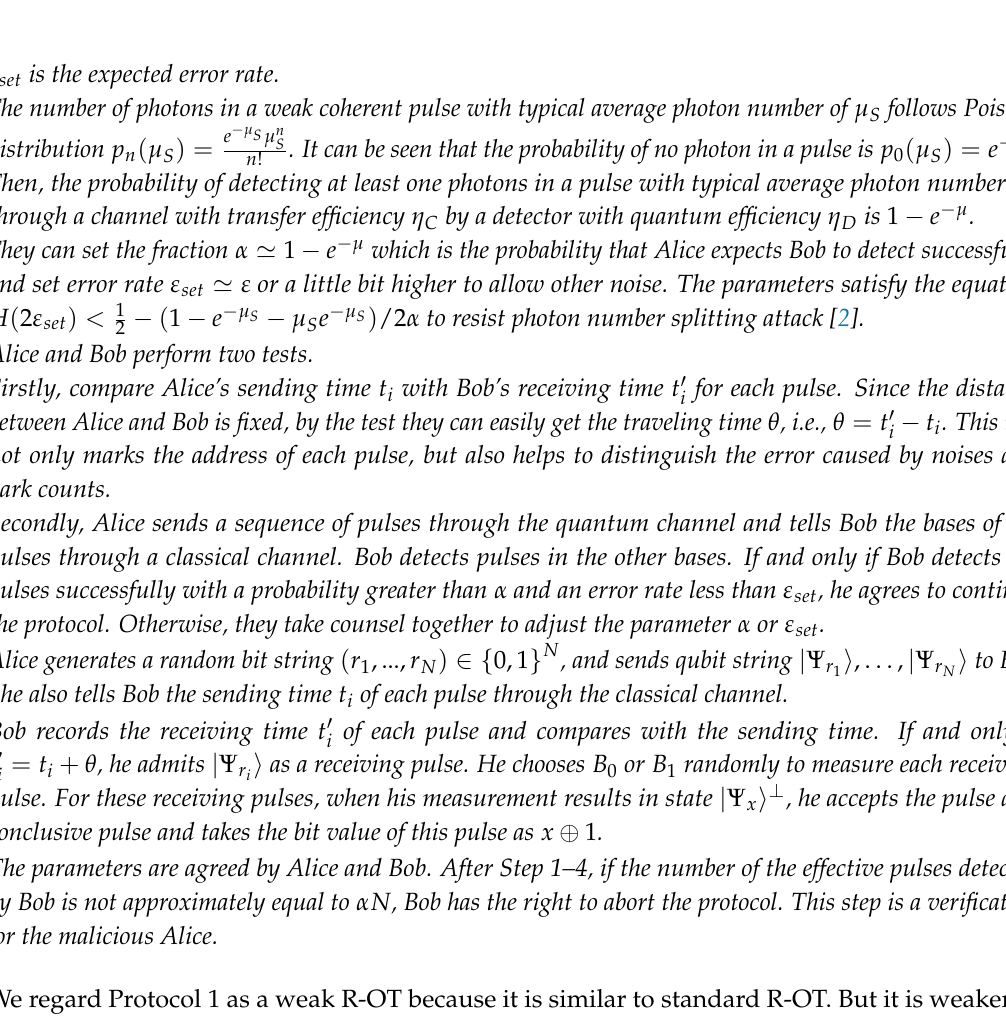
Protocol 2. Practical weak quantum OT 2